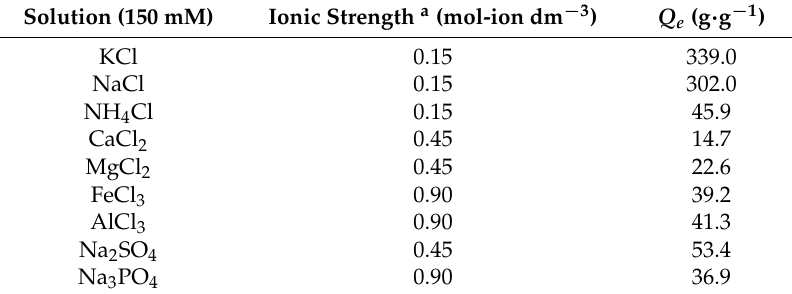
Figure 4. Water absorption of SD-PAA in ( a ) KCl, NaCl, NH 4 Cl, CaCl 2 , MgCl 2 , FeCl 3 , and AlCl 3 ; ( b ) NaCl, Na 2 SO 4 , and Na 3 PO 4 aqueous solutions, and ( c ) salt sensitivity factor ( f ) of different salt with concentration of 150 mM. Table 2. Effect of saline on the balanced water absorption.